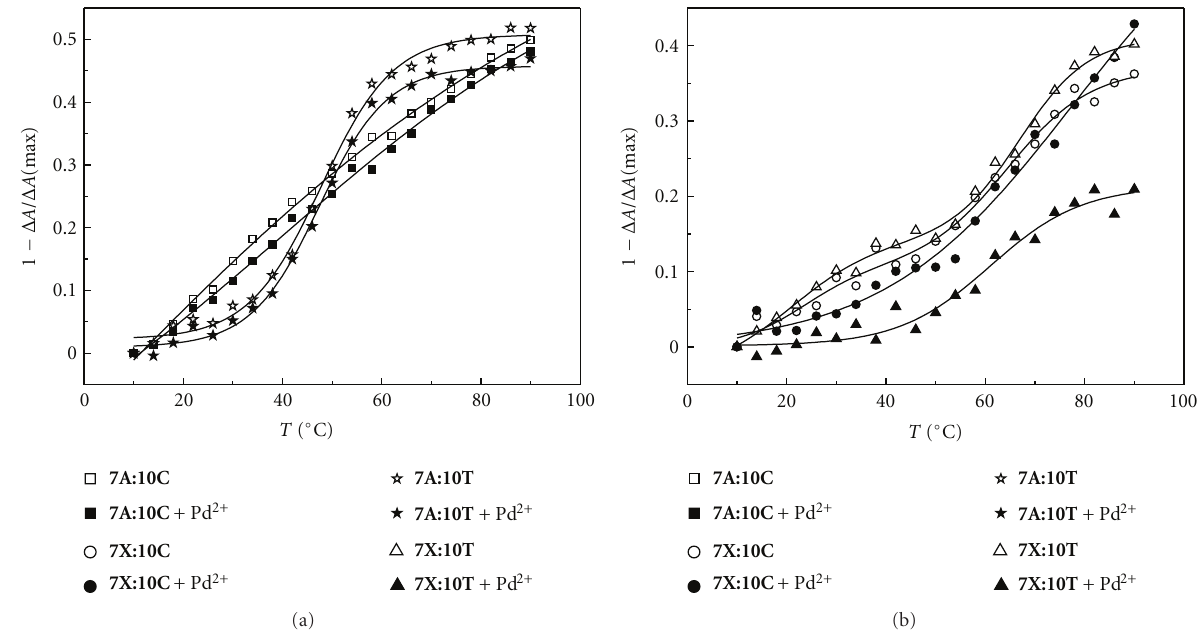
Figure 5: Temperature versus 1 − Δ A / Δ A (max) profiles of the duplexes formed between the modified ( 7X ) and unmodified ( 7A ) oligonucleotides with the DNA oligonucleotides 10C and 10T in the presence and absence of Pd 2+ ; [oligonucleotides] = 3.0 μ M, [K 2 PdCl 4 ] = 0/3.0 μ M, scan range 220–320 nm; I (NaClO = 0.1mol L − 1 ; pH = 7.4. 4 )